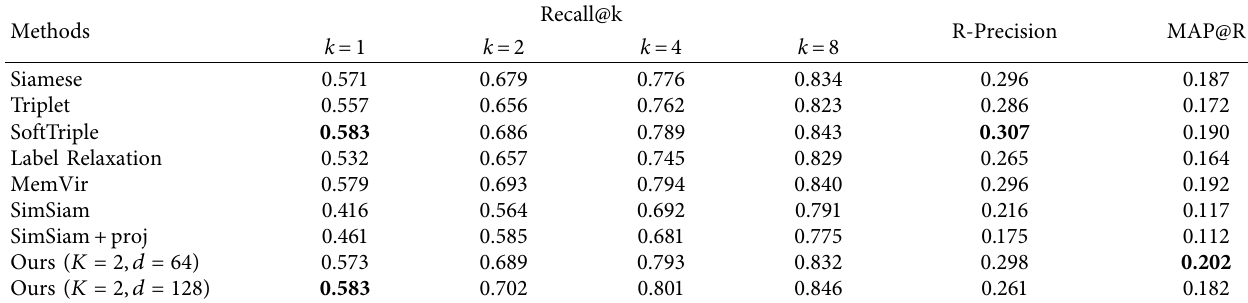
Table 4: Accuracy on Flickr 30k. K and d denote the number of embeddings and dimensions of metric embedding, respectively. Methods